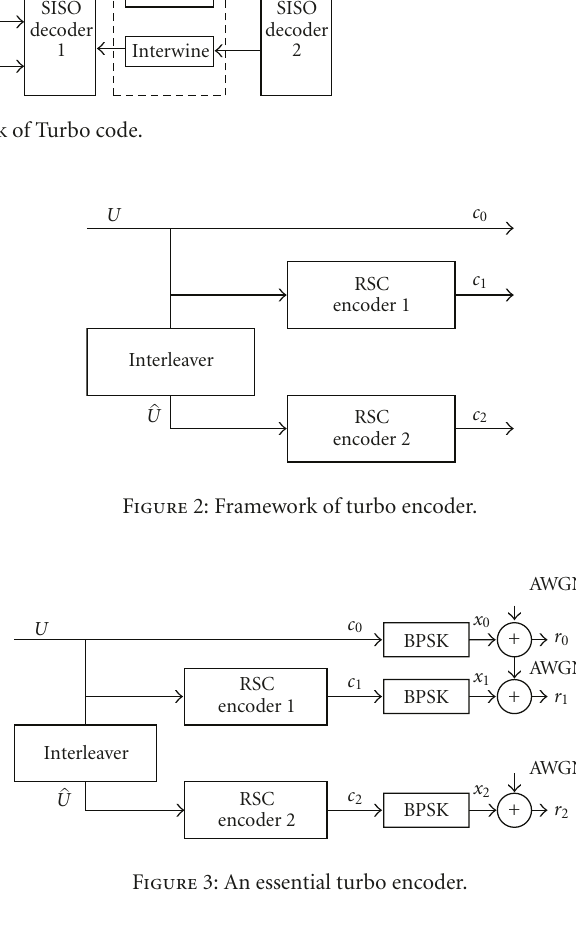
Figure 3 is an essential turbo encoder in which Binary Phase Shift Keying (BPSK) can convert analog signals into digital signals using plural wave combination of the devi- ation phase to represent phase-shift keying of information. (AWGN stands for Additive white Gaussian